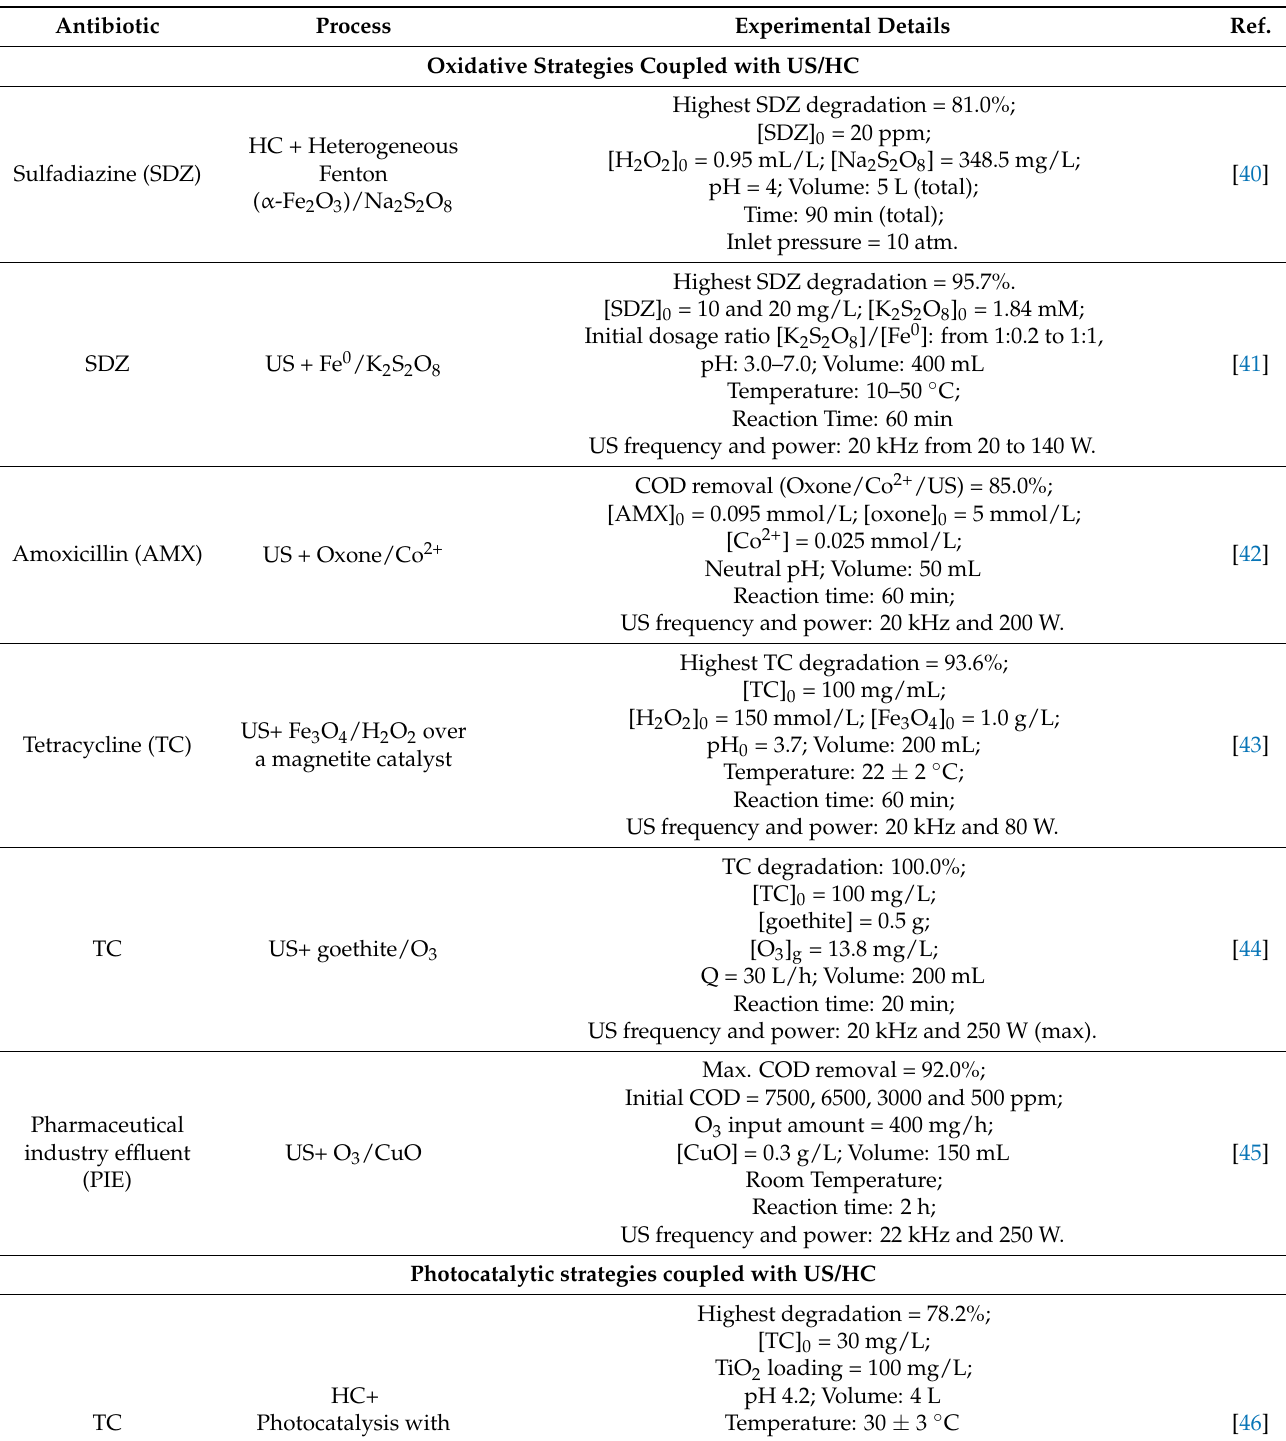
Table 1. Cavitational treatments for the degradation of antibiotics in wastewater: case studies reviewed. Antibiotic Process Experimental Details